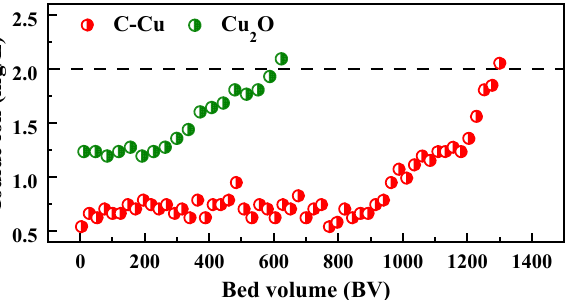
Figure 6. Column adsorption of iodide ions onto Cu 2 O and C-Cu. C 0 = 2.0 mg/L, adsorbents 1.5 g, 25 °C, pH = 7.0 ± 0.2, Cl − = 150 mg/L, SO 42 − = 50 mg/L, NO 3 − = 50 mg/L, F − = 50 mg/L, ReO 4 − = 10 mg/L, HCO 3 − = 50 mg/L, 20 BV/h.